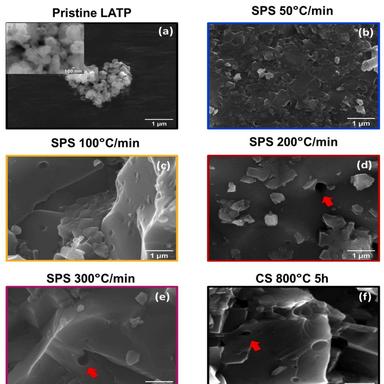
Secondary Electron HR-SEM images of pristine LATP powder (a), samples sintered by SPS at 750◦C during 5 min and using heating rates of 50 ◦C/min (b), 100 ◦C/min (c), 200 ◦C/min (d) and 300 ◦C/min (e), and the conventional sintering sample (f). The red arrows identify clear holes in densified powders and suggest possible gas loss during sintering.